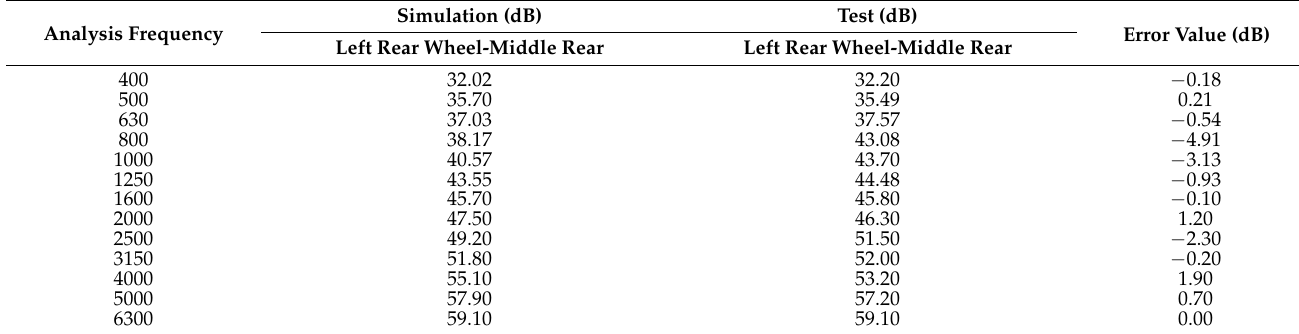
Table 7. Left rear wheel excitation test results.